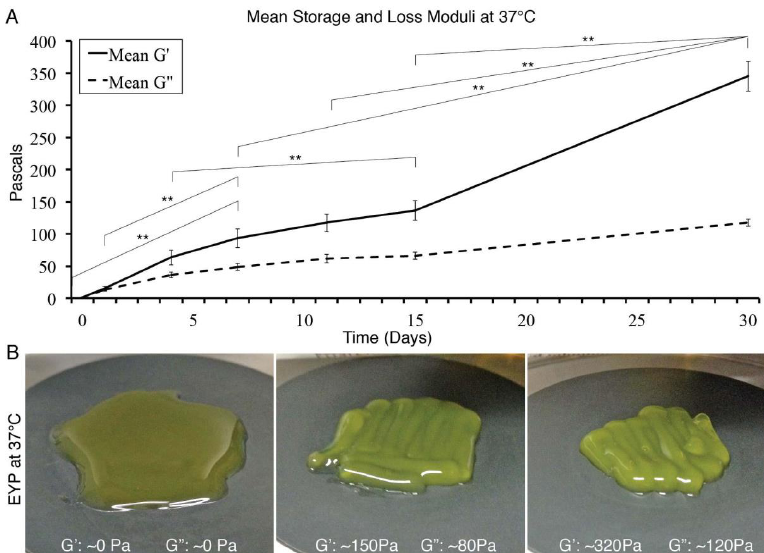
Figure 3. Viscoelastic properties of freeze thawed gelled EYP measured at 37 ◦ C, 0.1Hz, and 0.1%. Error bars show the standard error and statistical significance p-value < 0.01 only shown for G’. Statistical significance was calculated using one-way ANOVA, followed by Tukey’s Post-Hoc test. ( A ) G EYP’s viscoelastic properties after freeze thaw treatment; ( B ) Images of EYP at 37 ◦ C without freeze thaw (left), freeze thaw treatments for 15 days (centre) and 30 days (right). Materials 2019 , 12 , x FOR PEER REVIEW